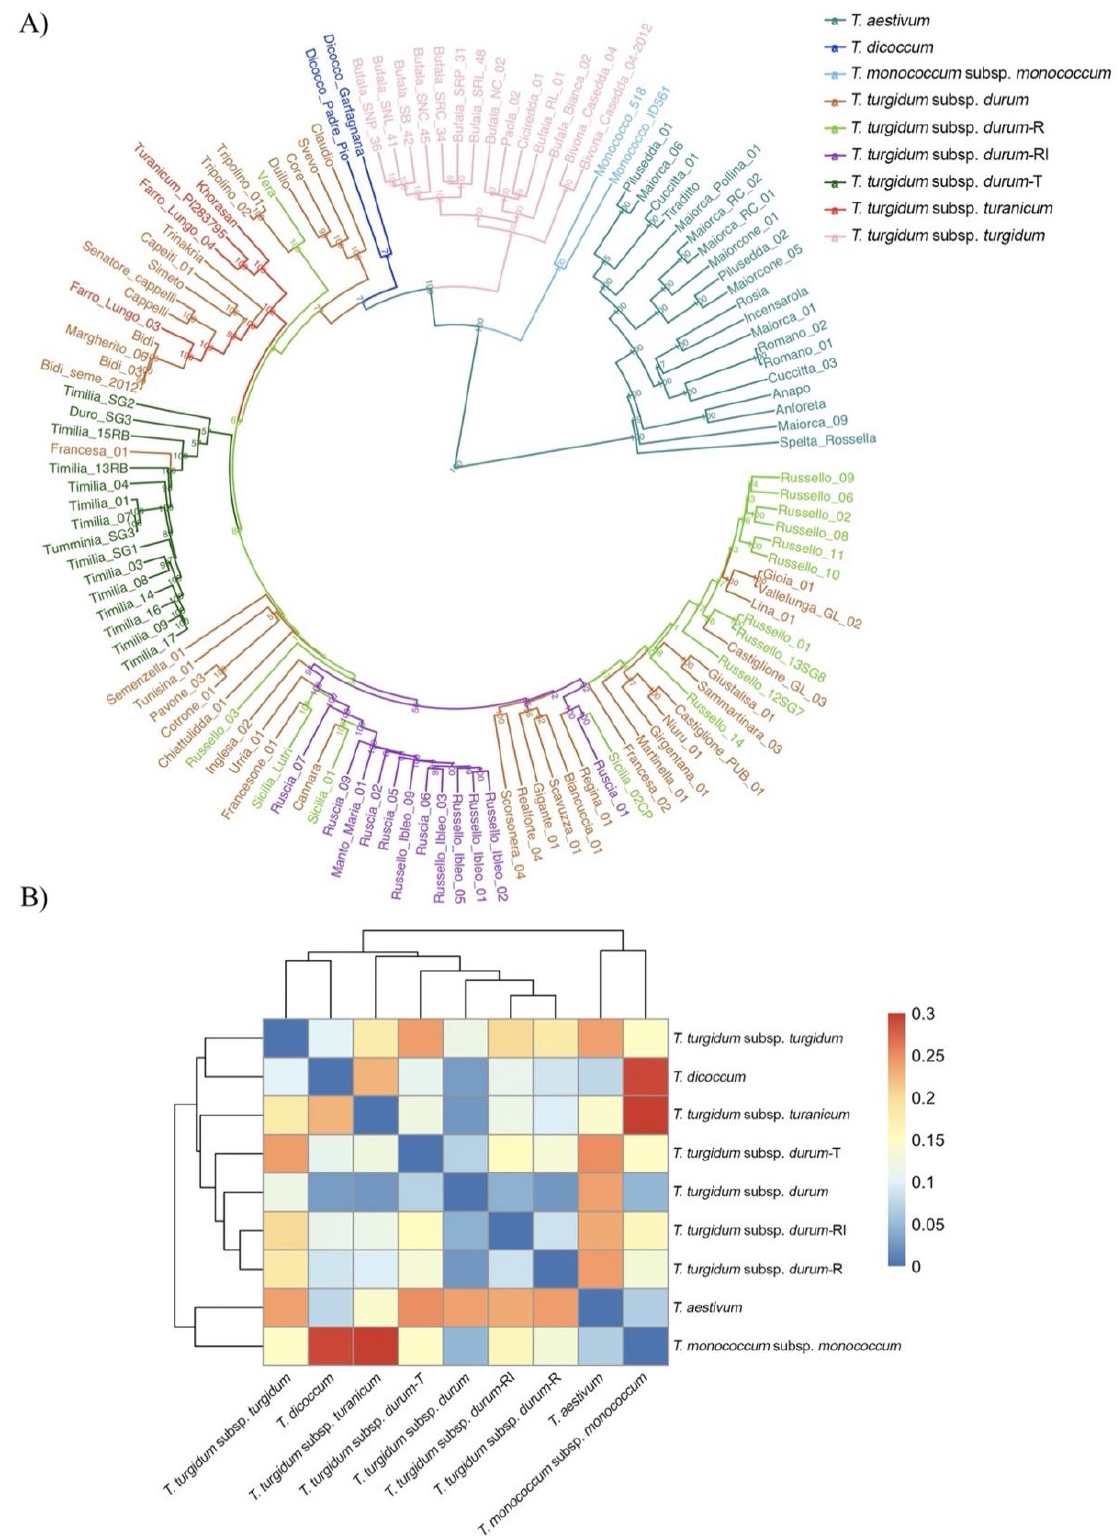
Figure 1. Genetic diversity of 126 wheat genotypes analyzed in the 90k SNP array. ( A ) UP- GMA dendrogram. The varieties are highlighted based on their species and membership group (Table S1). ( B ) Heatmap based on the population pairwise fixation index ( Fst ) evaluated among the wheat species and groups. R: Russello; RI: Russello Ibleo; T: